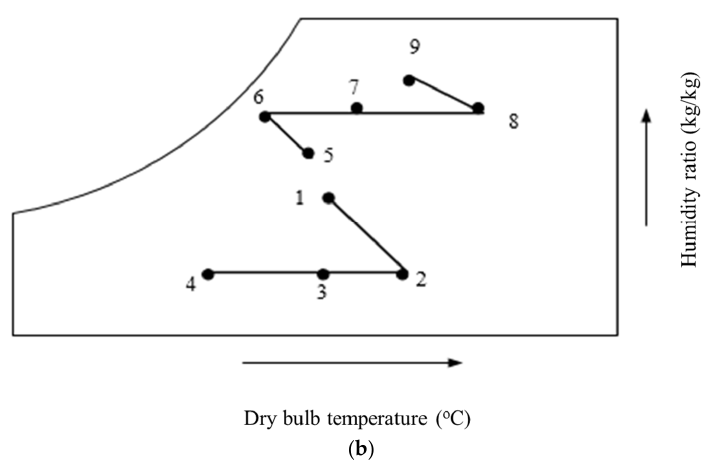
Figure 5. ( a ) Schematic diagram of a desiccant based evaporative cooling system; ( b ) psychrometric representation of processes.